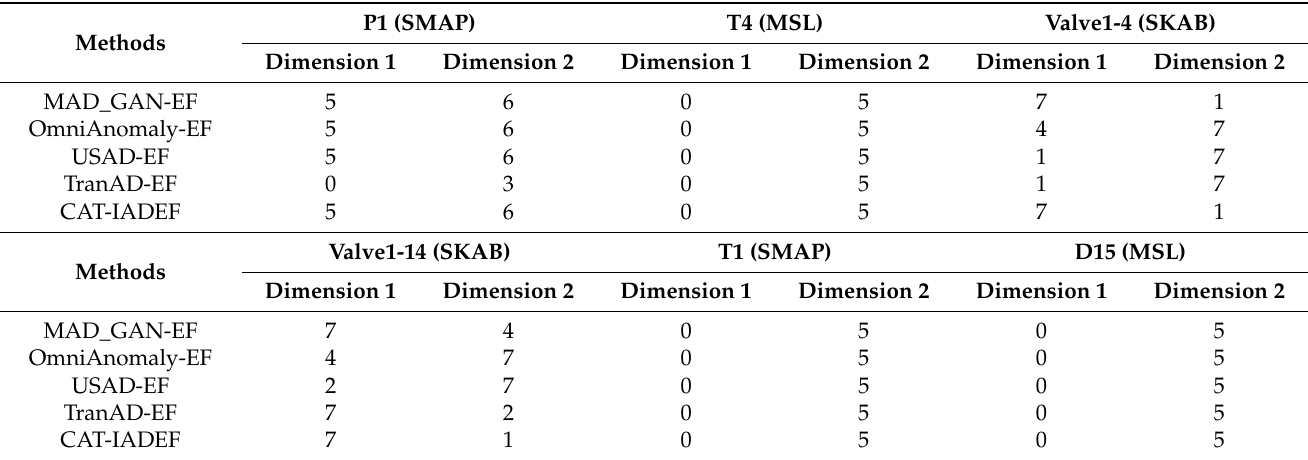
Table 4. Validation of anomaly explanation.